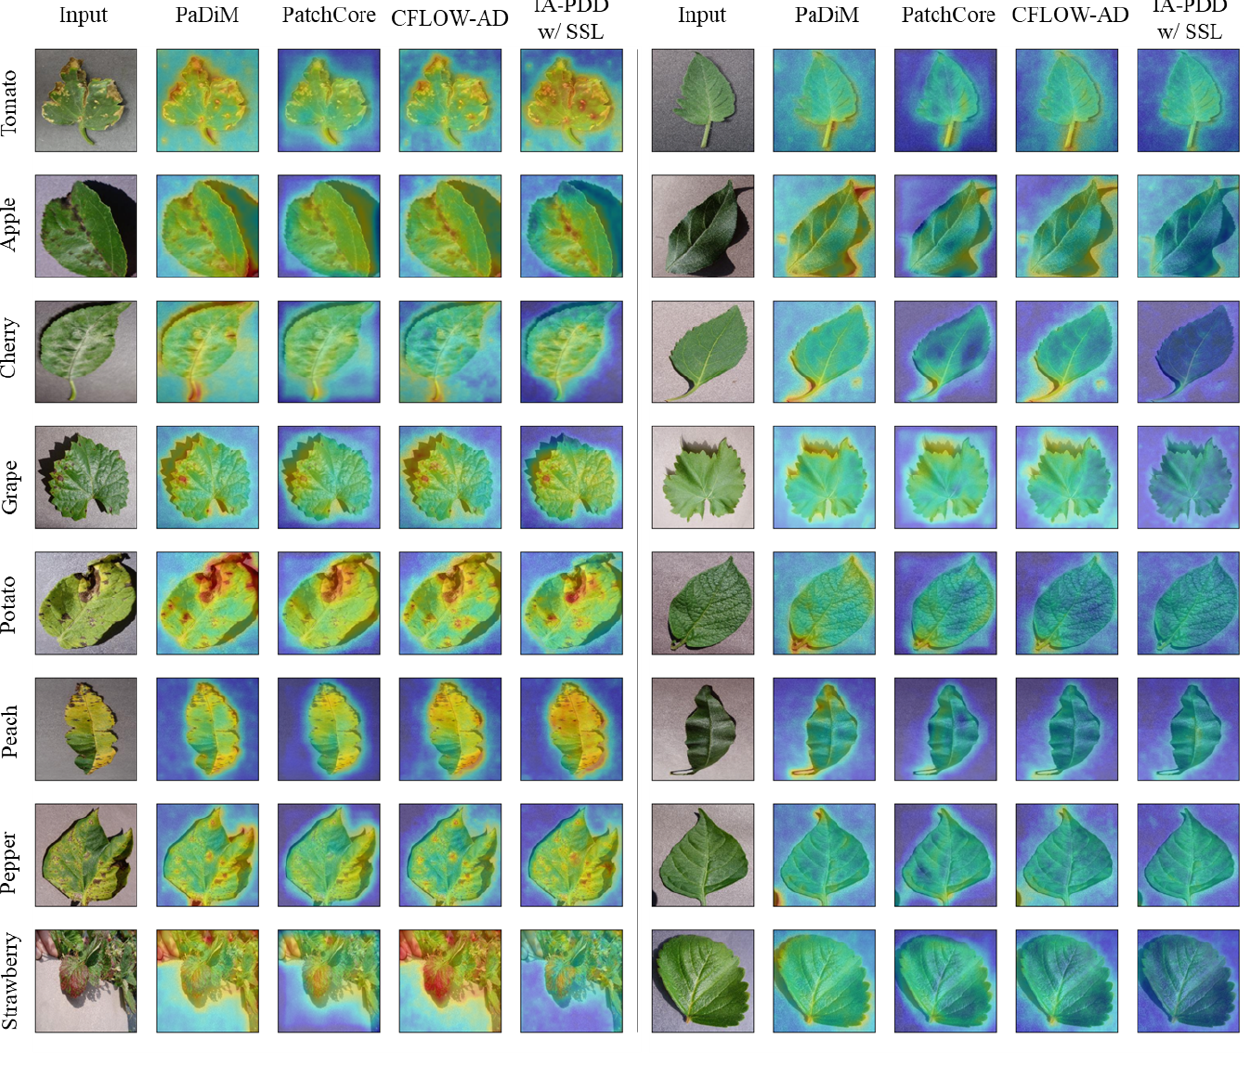
Figure 4. Qualitative results on PlantVillage dataset. The first five columns show the results of diseased leaves; the remaining columns show results of healthy leaves. Unlike the BRACOL dataset, there are 8 class categories of plant leaves, and no ground truth mask exists in the PlantVillage dataset. Therefore, we provide only heat maps for each class (rows) in comparison with the other state-of-the-art methods